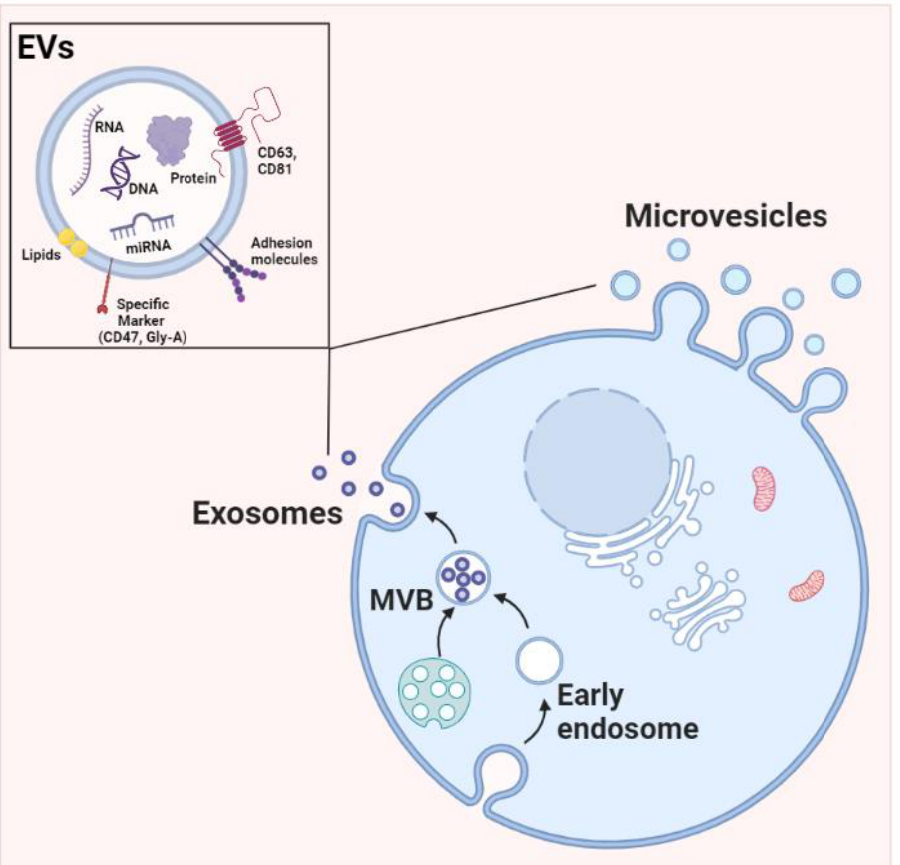
Figure 1. Scheme of biogenesis and typologies of cargoes of extracellular vesicles. Extracellular vesicles (EVs) generated via different mechanisms. Exosomes are produced from inward budding of the endosomal membrane. Microvesicles generated by outward budding of the plasma membrane. The outer EV membrane contains lipids and transmembrane proteins. EVs are also enriched in microRNAs, mRNAs, and proteins that mediate systemic effects. EVs are also known to contain metabolites and mitochondrial DNA. Created in Biorender.com, accessed on 6 December 2022.